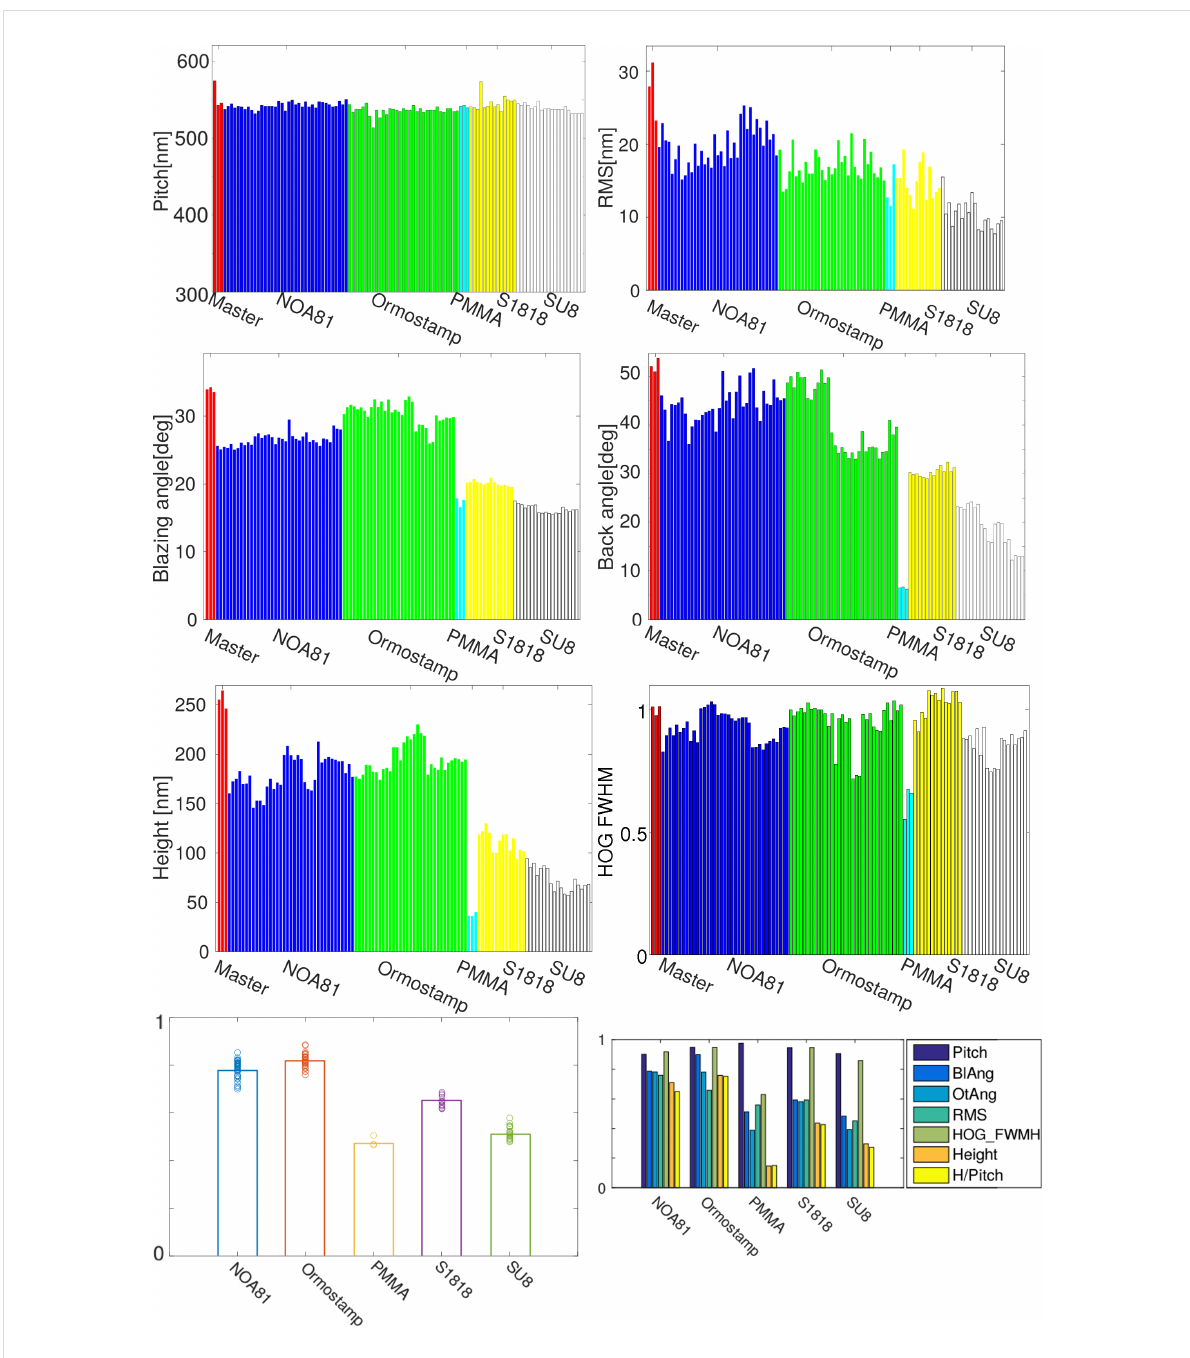
Figure 8: Summary of the results. The sample master and all 103 replica samples are presented. The bottom graphs are averaged figures of merit gathering all parameters (left) and singularizing every parameter (right).